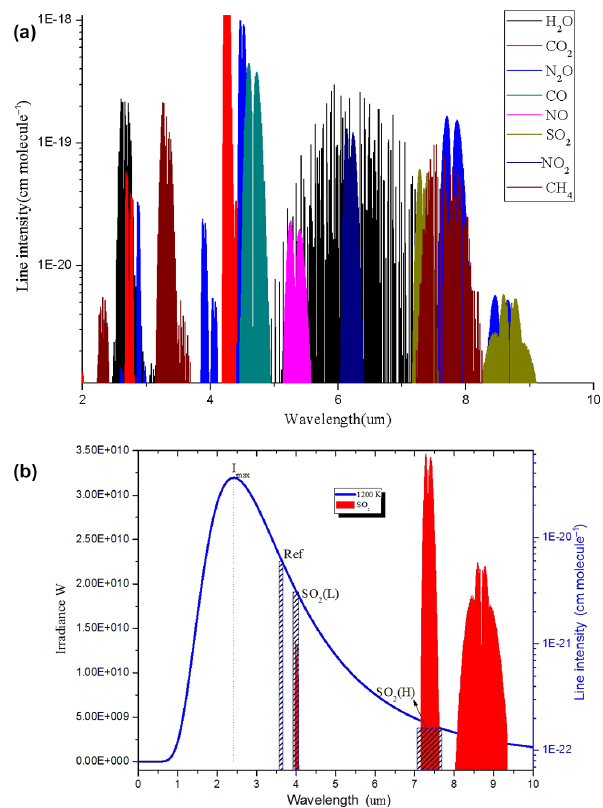
Figure 2. Absorption spectra of typical absorbers between 2 and 10µm obtained from the HITRAN database. The curves are in linear–log plots. (a) Absorption spectra of all typical absorbers. Ob- vious cross-absorptions with each other are shown. (b) Overview of the radiation distribution of the light source, the bandwidths of Ref, SO 2 (L) and SO 2 (H) filters, and the absorption spectra of SO 2 . Three obvious absorption wavebands at 4, 7.32, and 8.5µm are shown. Their line strengths ranked as 7.32µm > 8.5µm > 4µm, with values of 10 − 19 , 10 − 20 , and 10 − 21 cmmolecule − 1 , respec-